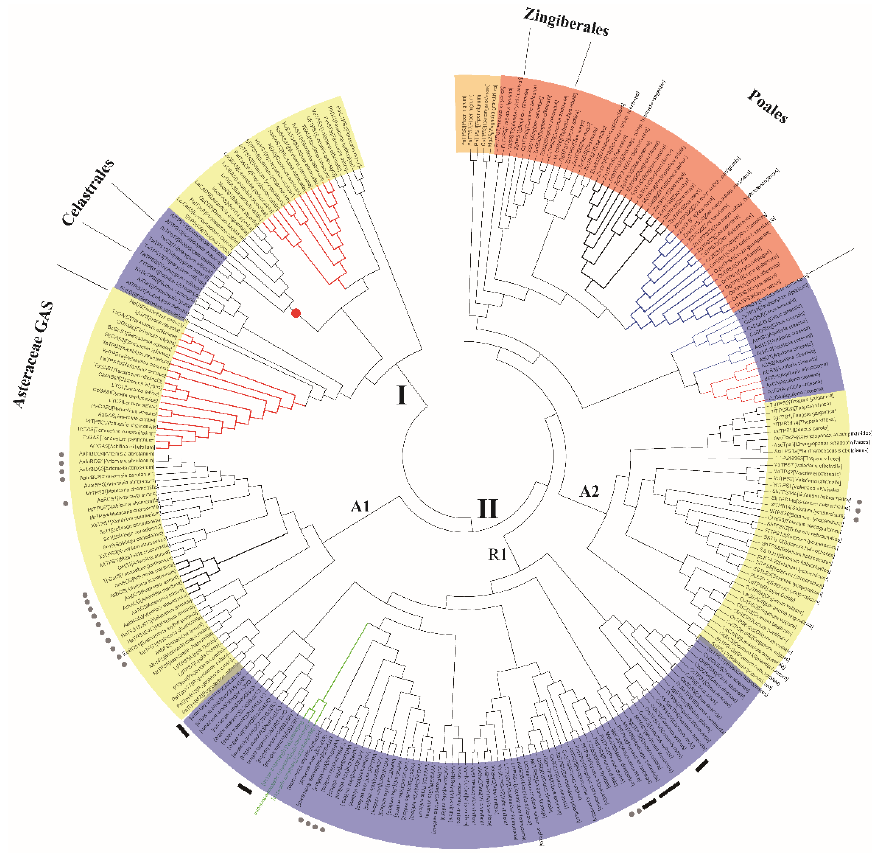
Figure 7. The phylogeny of spermatophyte STSs in the TPS-a subfamily. Blue shadow represents the Rosanae STSs, yellow shadow represents the Asterids STSs, red shadow represents the monocot STSs, and orange shadow represents the magnoliid STSs. Red branches show the STSs with identical products, blue branches show the STSs with 1,11-cyclized functions and green branches show the probable HGT members from Santalum album . STSs producing 1,6-cyclized sesquiterpenes are marked with grey dots, and the neighbor STSs producing 1,10- or 1,11-cyclized products, respectively, are marked with black